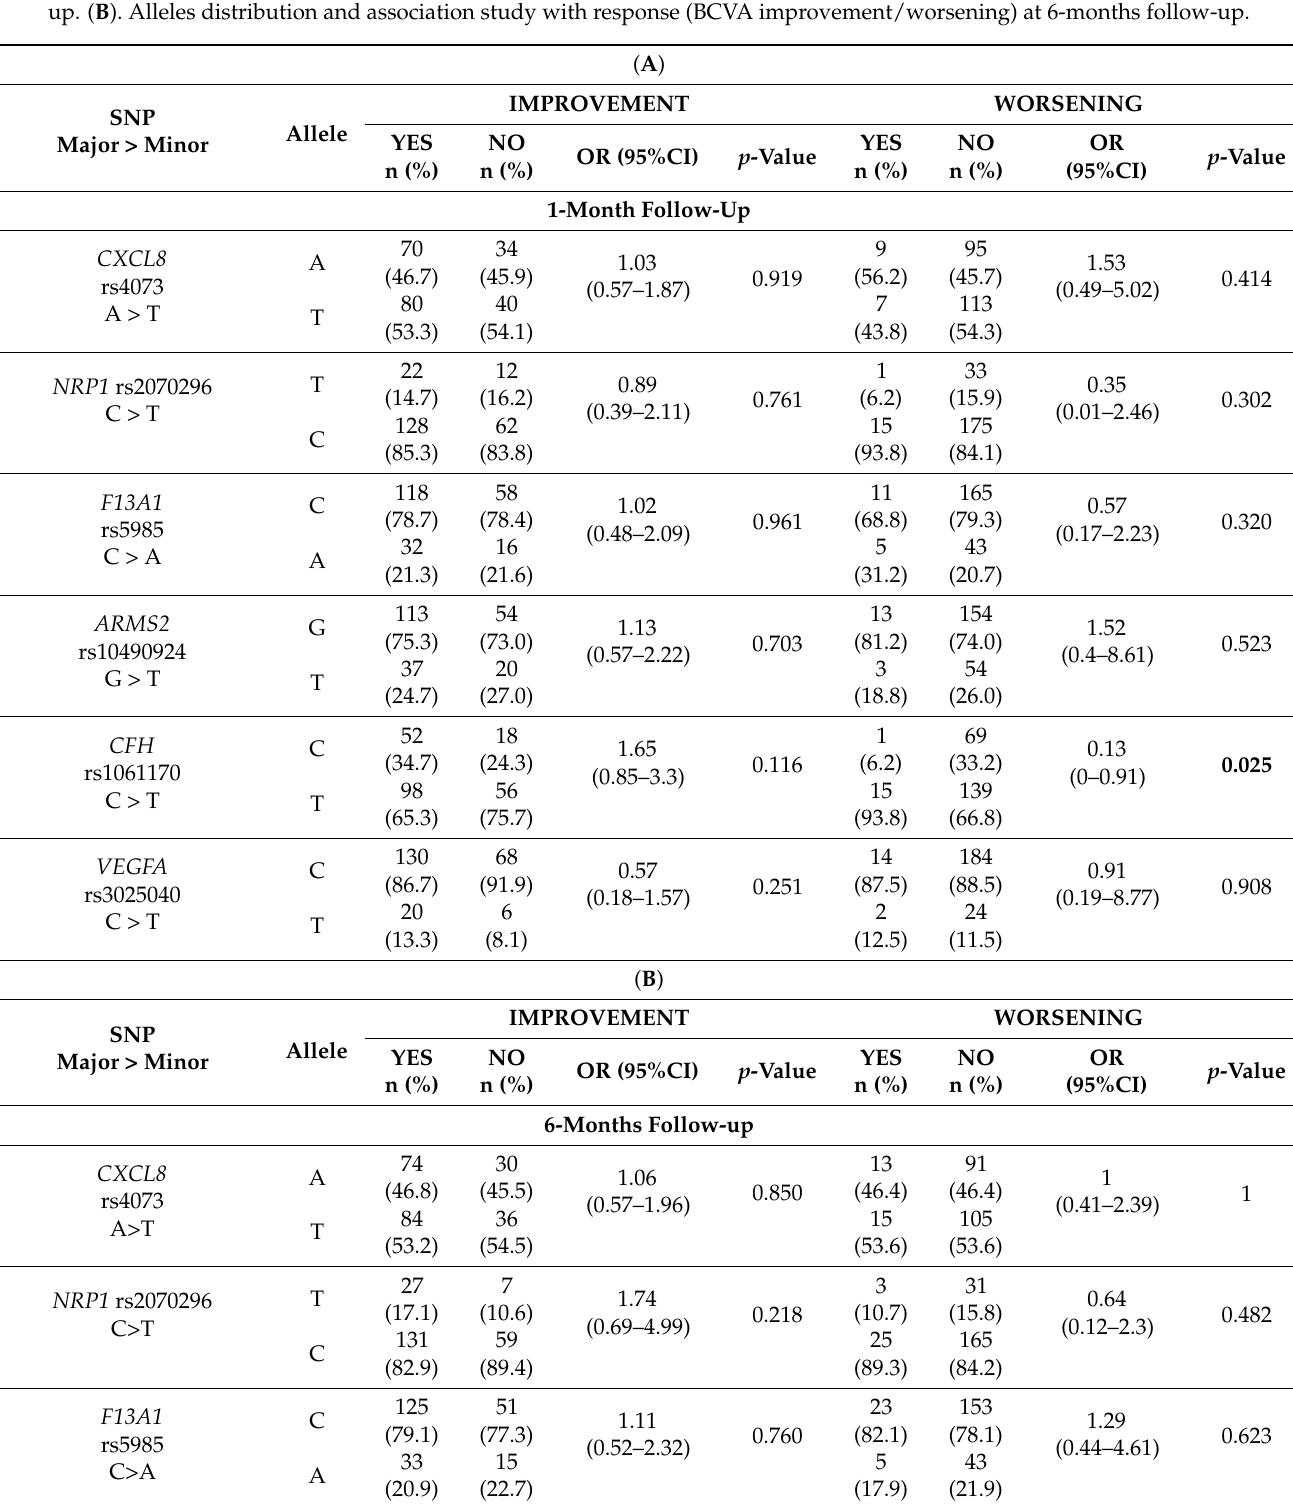
Table 4. ( A ). Alleles distribution and association study with response (BCVA improvement/worsening) at 1-month follow- up. ( B ). Alleles distribution and association study with response (BCVA improvement/worsening) at 6-months